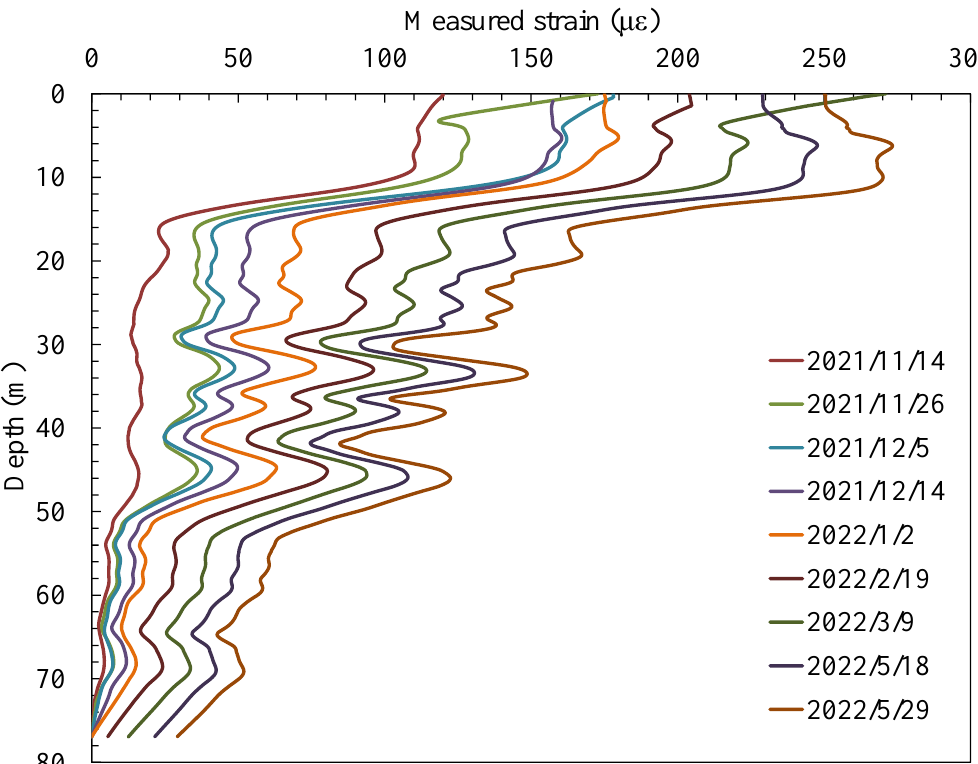
Figure 7. Measured strain during construction of building.